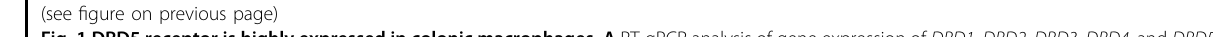
Fig. 1 DRD5 receptor is highly expressed in colonic macrophages. A RT-qPCR analysis of gene expression of DRD1 , DRD2 , DRD3 , DRD4 , and DRD5 in IECs (CD45 - Epcam + ) and LP cells (CD45 + Epcam - ) isolated from WT mice ( n = 3 mice per group). B RT-qPCR analysis of gene expression of DRD1 , DRD4 , and DRD5 in T cells, B cells, NK cells, DC cells, monocytes, neutrophils, macrophages, and ILCs cells isolated from the colonic LP of WT mice ( n = 3 mice per group). C Immuno fl uorescent labeling of TH (green), Cx3cr1(red), and DAPI (blue) in colon sections from Cx3cr1 reporter mice. The close proximity of macrophages with dopaminergic neurons is indicated by arrow. Scale bar, 30 µm. D Immuno fl uorescent labeling of DRD5 (green), F4/80 (red), and DAPI (blue) in colon sections from WT mice. The merging of DRD5 with F4/80 + in macrophages indicated by the arrowhead. Scale bar, 30 µm. E Immuno fl uorescent labeling of DRD5 (green), Arg1(red), and DAPI (blue) in colon sections from WT mice. The merging of DRD5 with Arg1 + in macrophages indicated by the arrowhead. Scale bar, 30 µm. F Immuno fl uorescent labeling of DRD5 (green), Inos (red), and DAPI (blue) in colon sections from WT mice. The merging of DRD5 with Inos + in macrophages indicated by the arrowhead. Scale bar, 30 µm. Data are pooled from three independent experiments ( A , B ). Error bars show means ± SEM. *** p < 0.001. Two-tailed unpaired student ’ s t